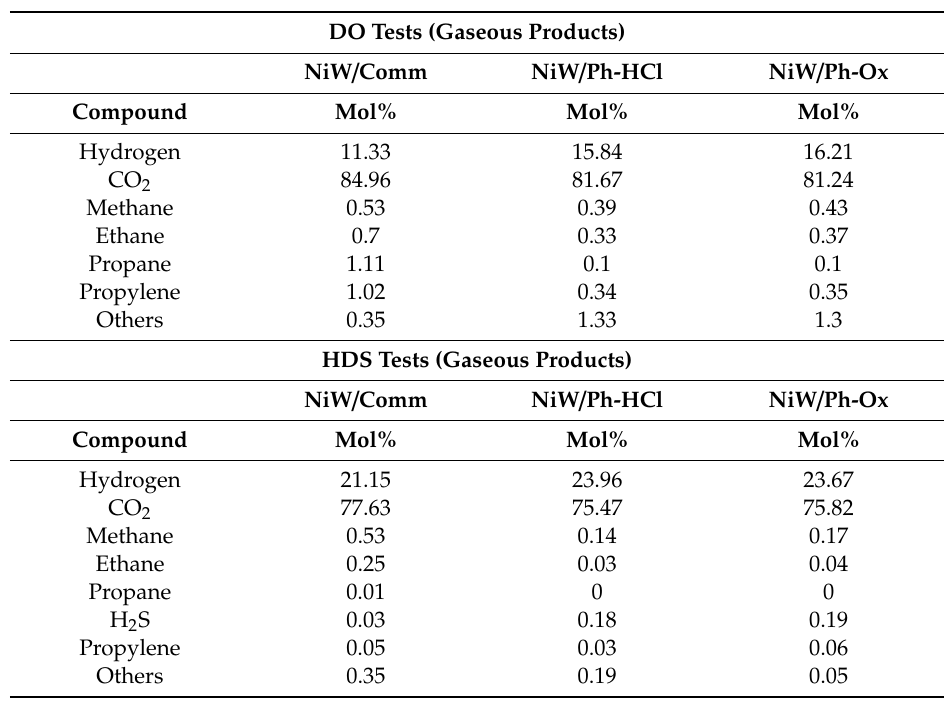
Figure 5. SimDis for the hydrodesulfurization (HDS) products and feedstock. Table 7. Refinery Gas Analysis methodology (RGA) analyses for gases obtained from the DO and HDS tests using the commercial and laboratory catalysts.